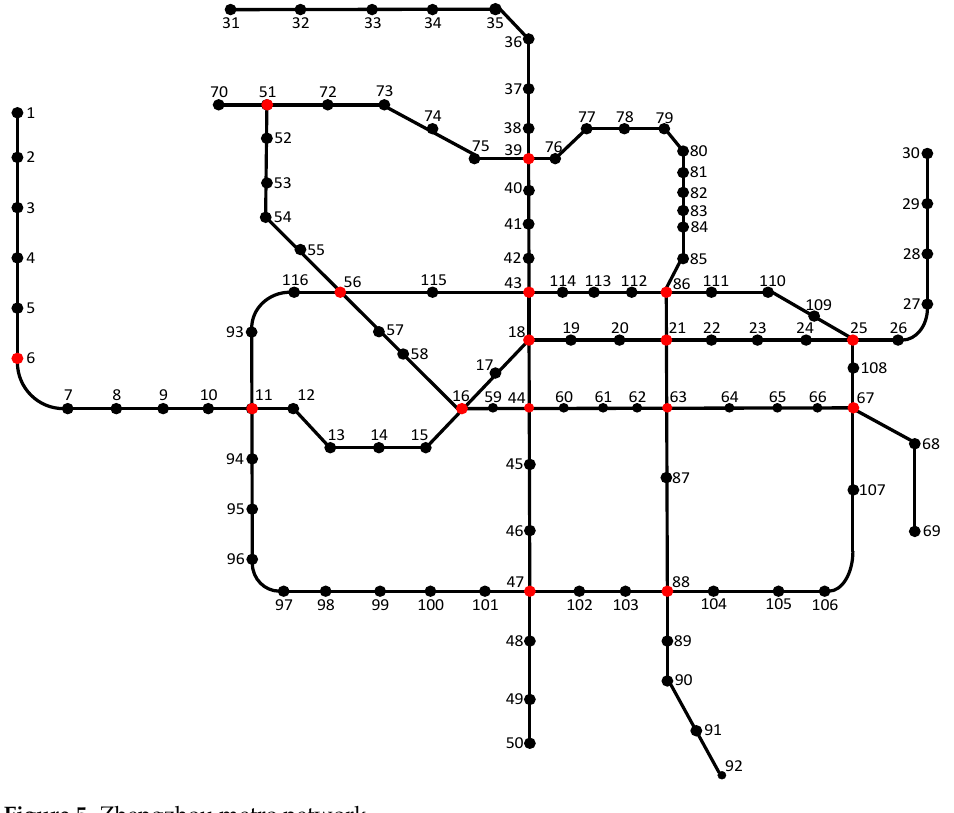
Figure 5. Zhengzhou metro network.